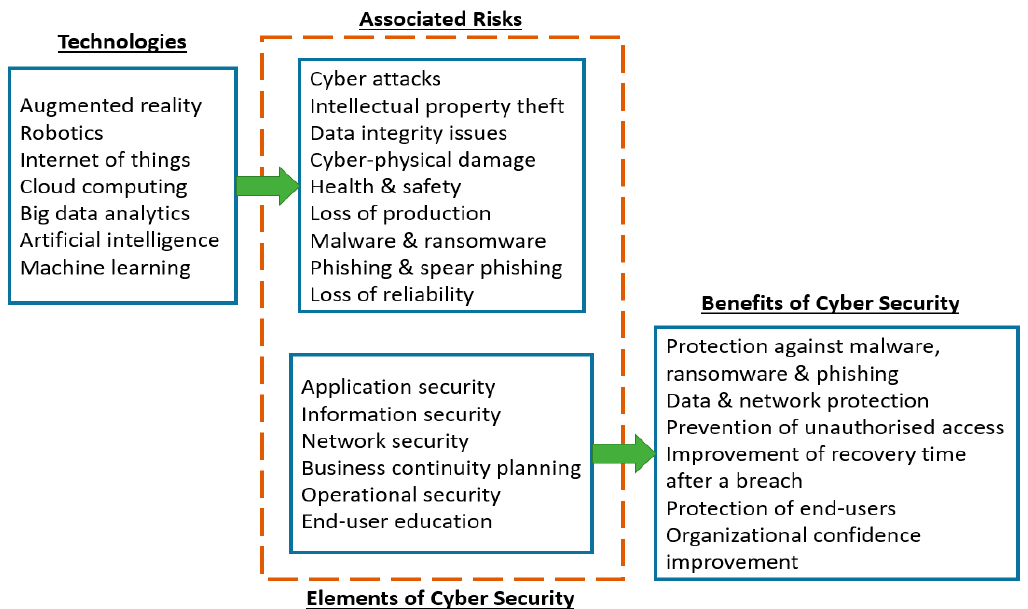
Figure 6. Overview of cyber security.